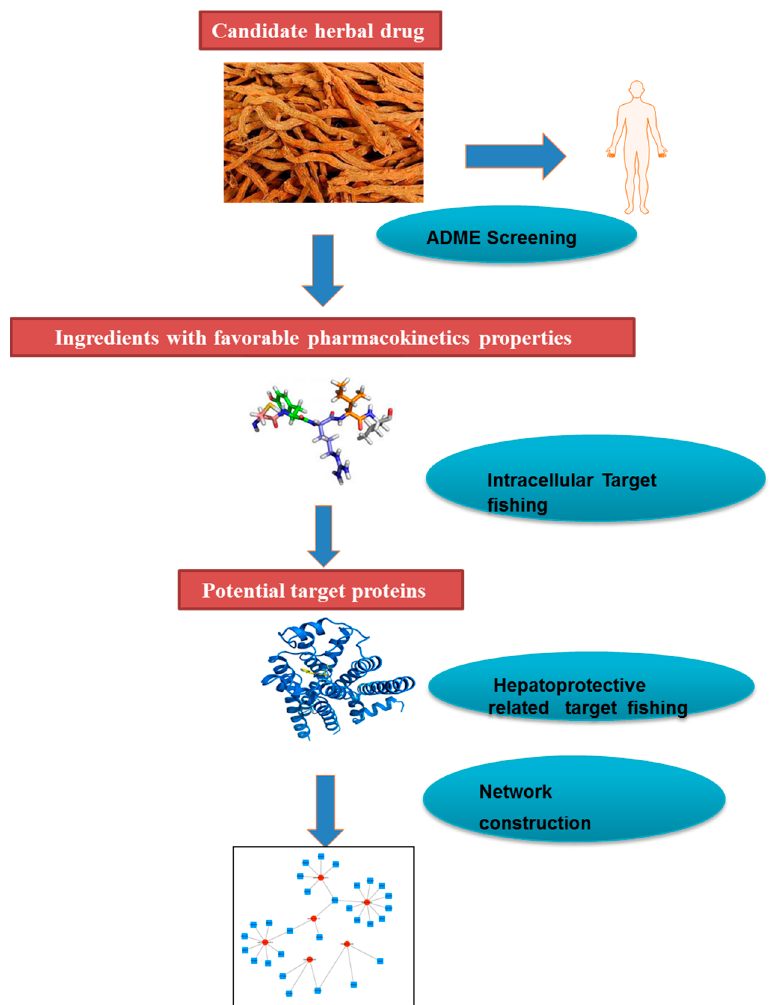
Figure 9. A flowchart to schematically describe the network pharmacology process.